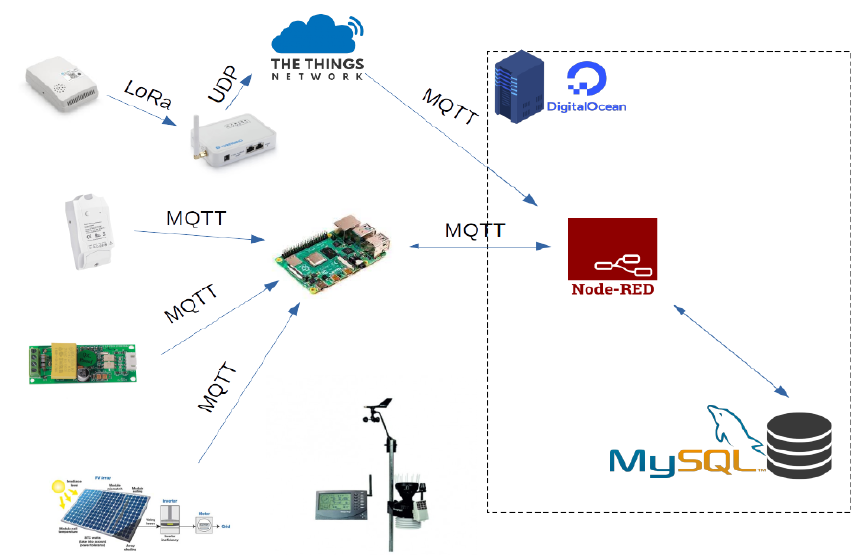
Figure 10. Schematic diagram for the complete system.